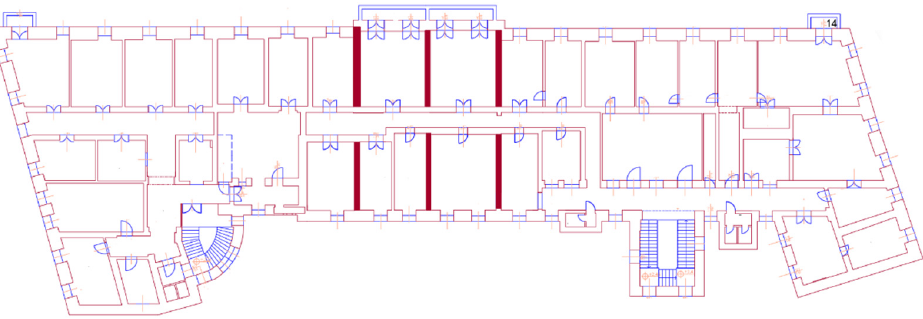
Figure 10. Floor plan of the Diocese in Pan č evo.